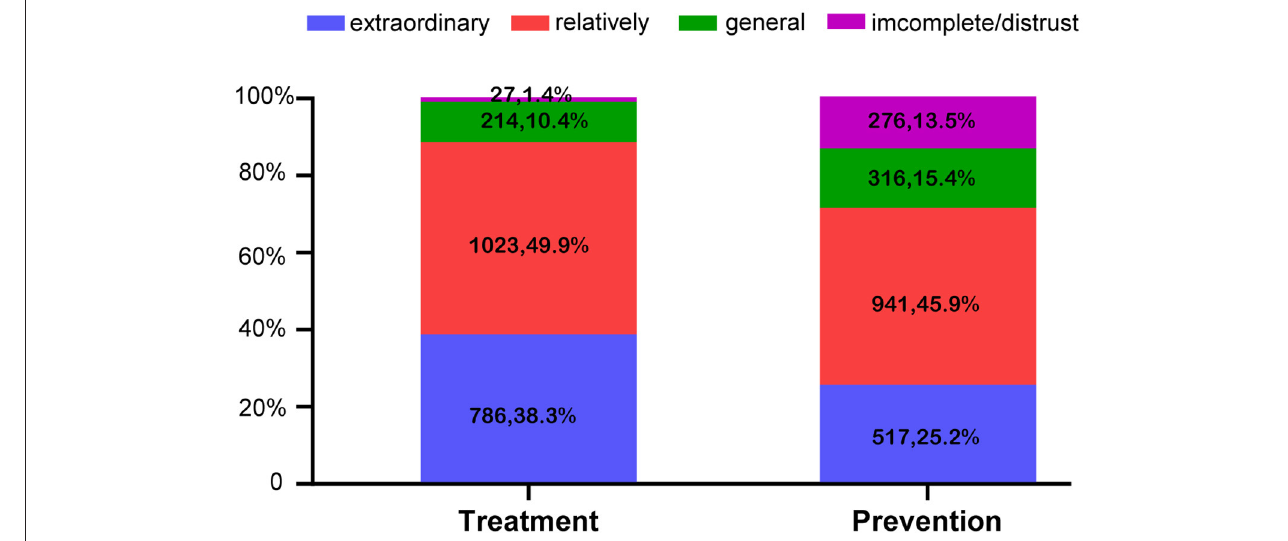
FIGURE 3 | Trust in using TCM to prevent and treat COVID-19 ( N = 2,050).